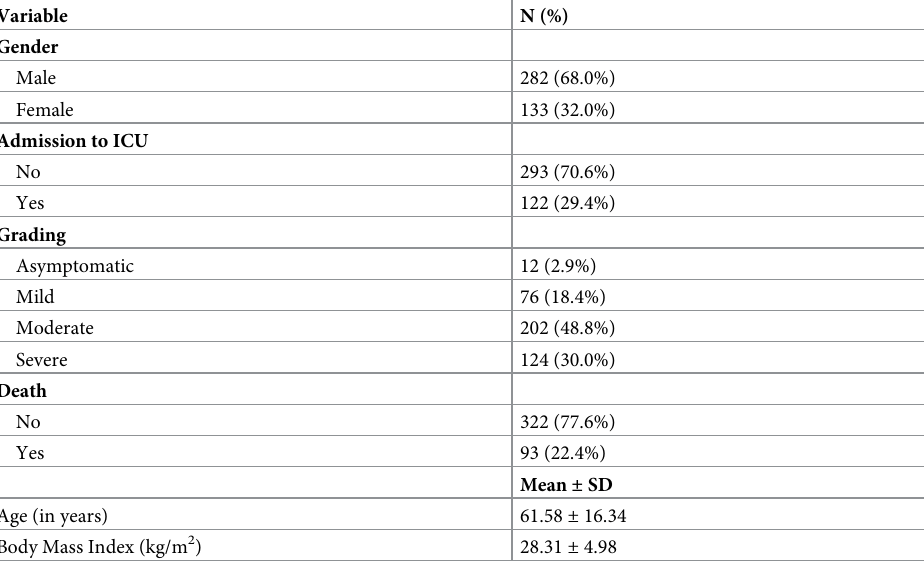
Table 1. Sociodemographic characteristics of the patients (N =